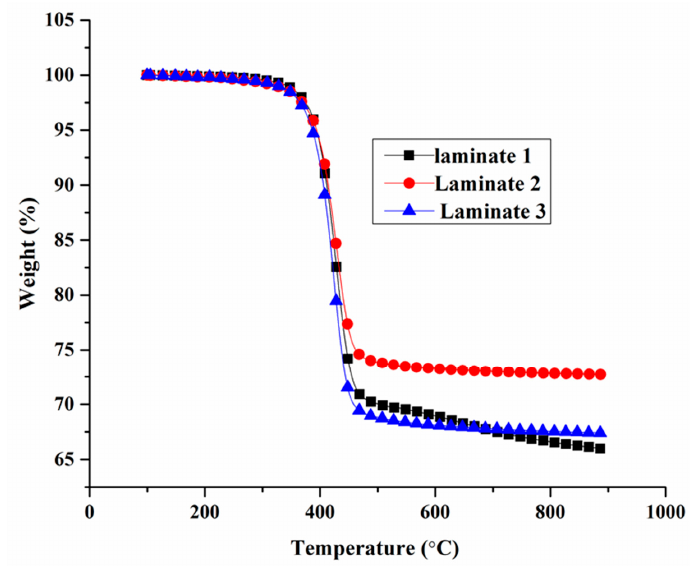
Figure 8. TG curve of different samples.